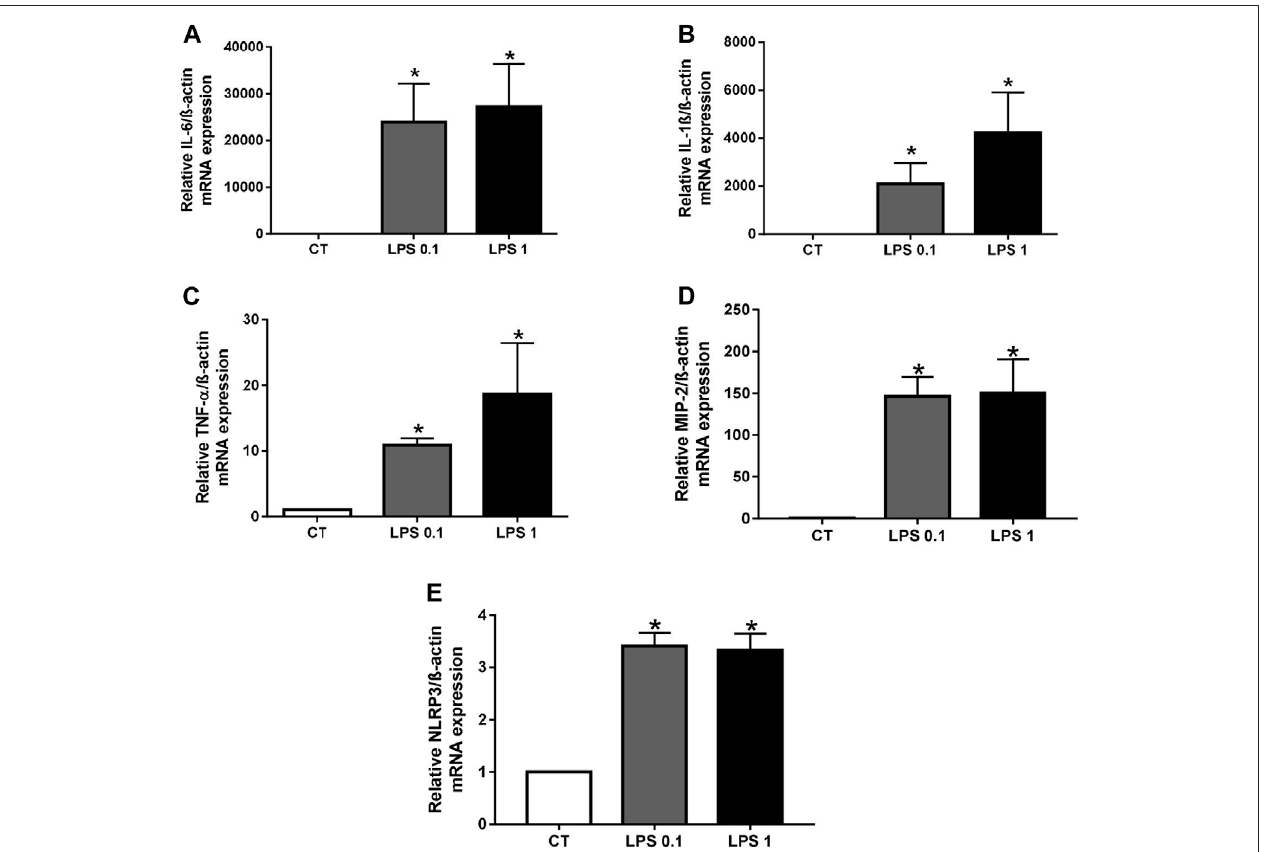
FIGURE 1 | Lipopolysaccharide-EK (LPS-EK) induces in fl ammation in macrophages. RAW cells were incubated with LPS-EK for 6 h. Gene expression of (A) IL-6, (B) IL-1 β , (C) TNF- α , (D) MIP-2, and (E) NLRP3 was quanti fi ed by quantitative real-time PCR and normalized to that of the housekeeping gene ß-actin. Data are expressed asthe mean ±SEM offour independent experiments performed intriplicate ( n =4). * p < 0.05 vs . CT,Mann-Whitneytest. LPS0.1: 0.1 µg/ml LPS-EK, LPS 1: 1 µg/ml LPS-EK.